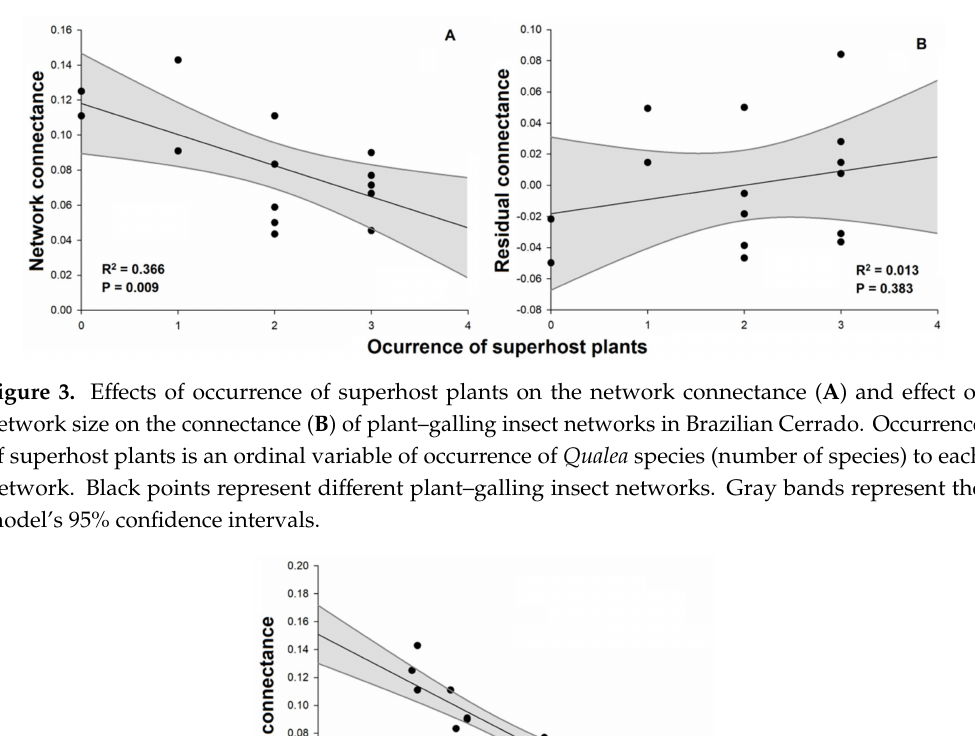
Figure 2. E ff ects of occurrence of superhost plants on the ( A ) number of observed interactions and ( B ) network size of plant–galling insect networks in Brazilian Cerrado. Occurrence of superhost plants is an ordinal variable of occurrence of Qualea species (number of species) to each network. Black points represent di ff erent plant–galling insect networks. Gray bands represent the model’s 95% confidence intervals.